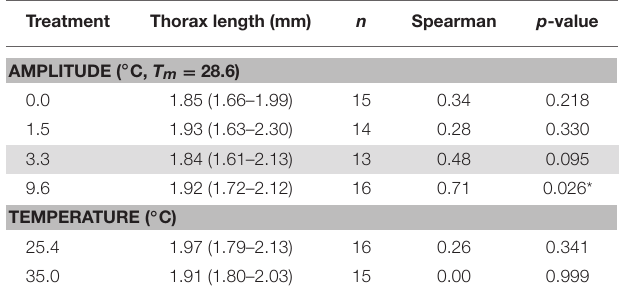
Mean values of thorax lengths are shown, minimum and maximum values of each group are indicated between parentheses. See Section Results for pupal developmental times. In each case, only ants that were still alive 48h after eclosion (i.e., ants later dissected for brain immunolabeling) were considered. The light gray bar indicates the daily thermal program preferred by C. mus nurses to maintain the brood. Asterisks denote significant